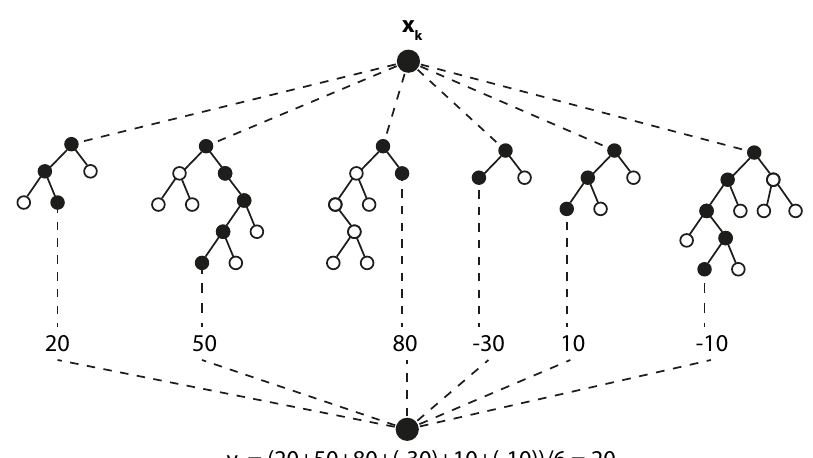
Figure 7. An arbitrary RF model consisting of 6 decision trees. The prediction, y k , of the data instance, x k , is determined by averaging the sum of the outputs from the decision trees. The filled nodes show the path x k has taken in each decision tree.